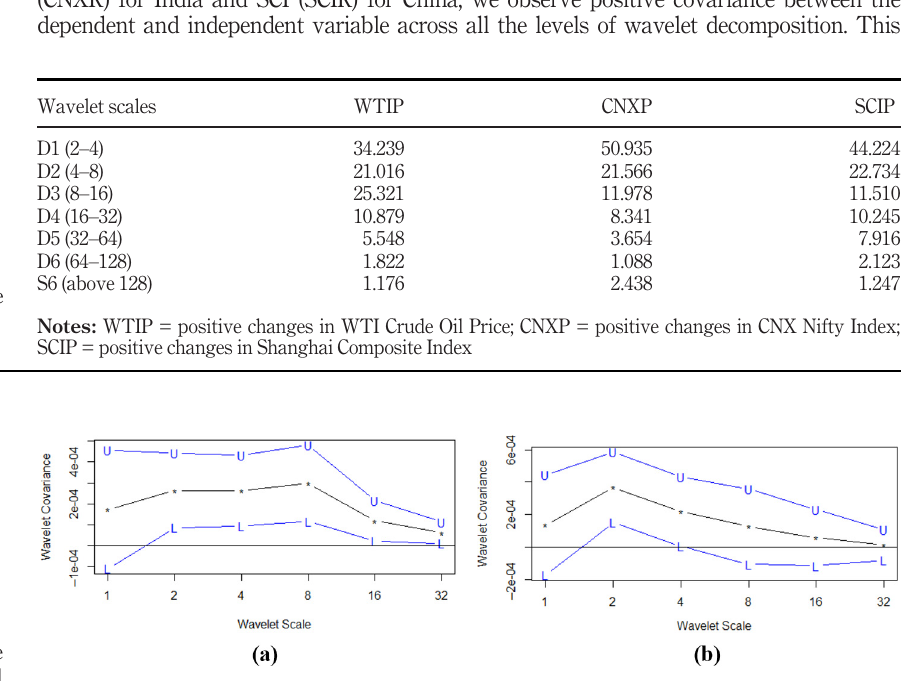
Figure 4. Wavelet covariance between WTIR and CNXR and SCIR